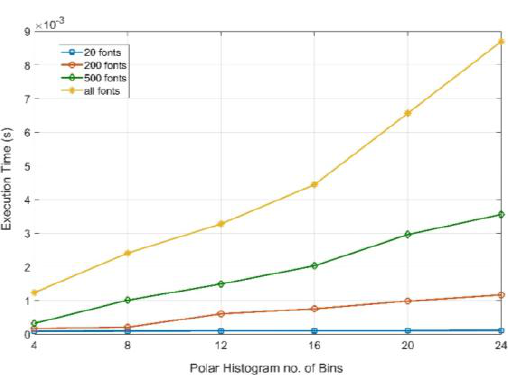
Fig. 7. Execution time for various font choices for all